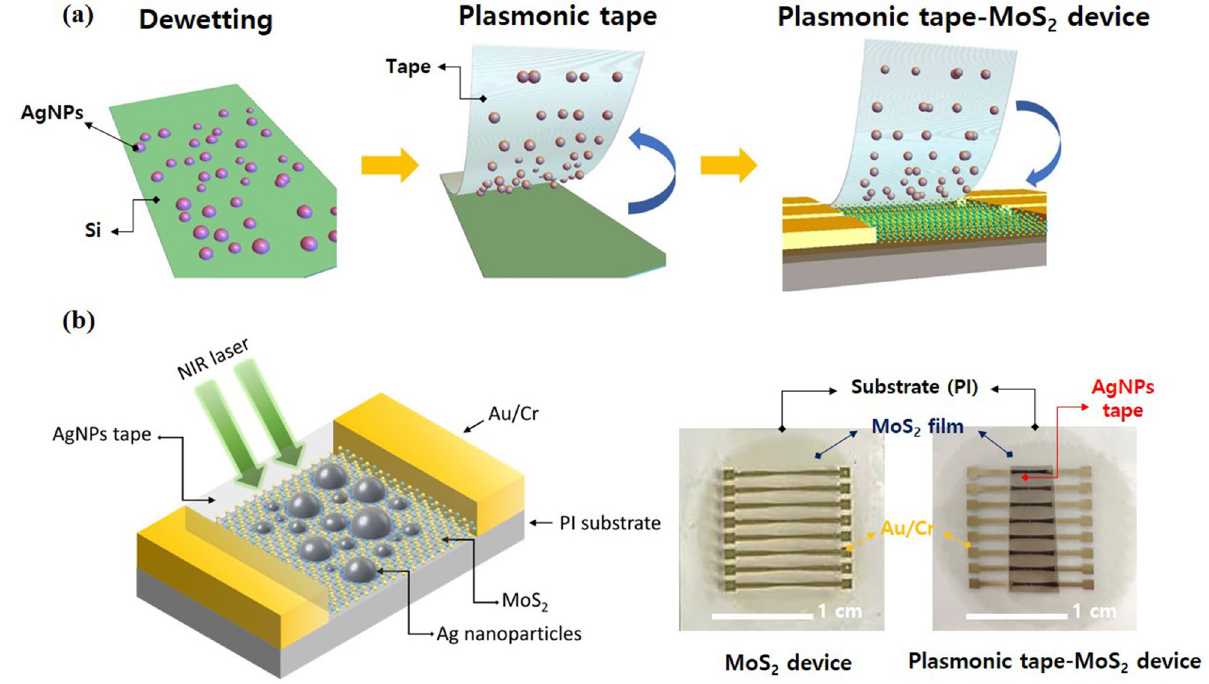
Figure 1. ( a ) Fabrication process of the MoS 2 photodetectors decorated with plasmonic AgNPs. Thermally dewetted AgNPs were detached from Si substrate using a 3 M tape and attached to the surface of a MoS 2 device. ( b ) Schematic illustration and photograph of the plasmonic-tape-MoS 2